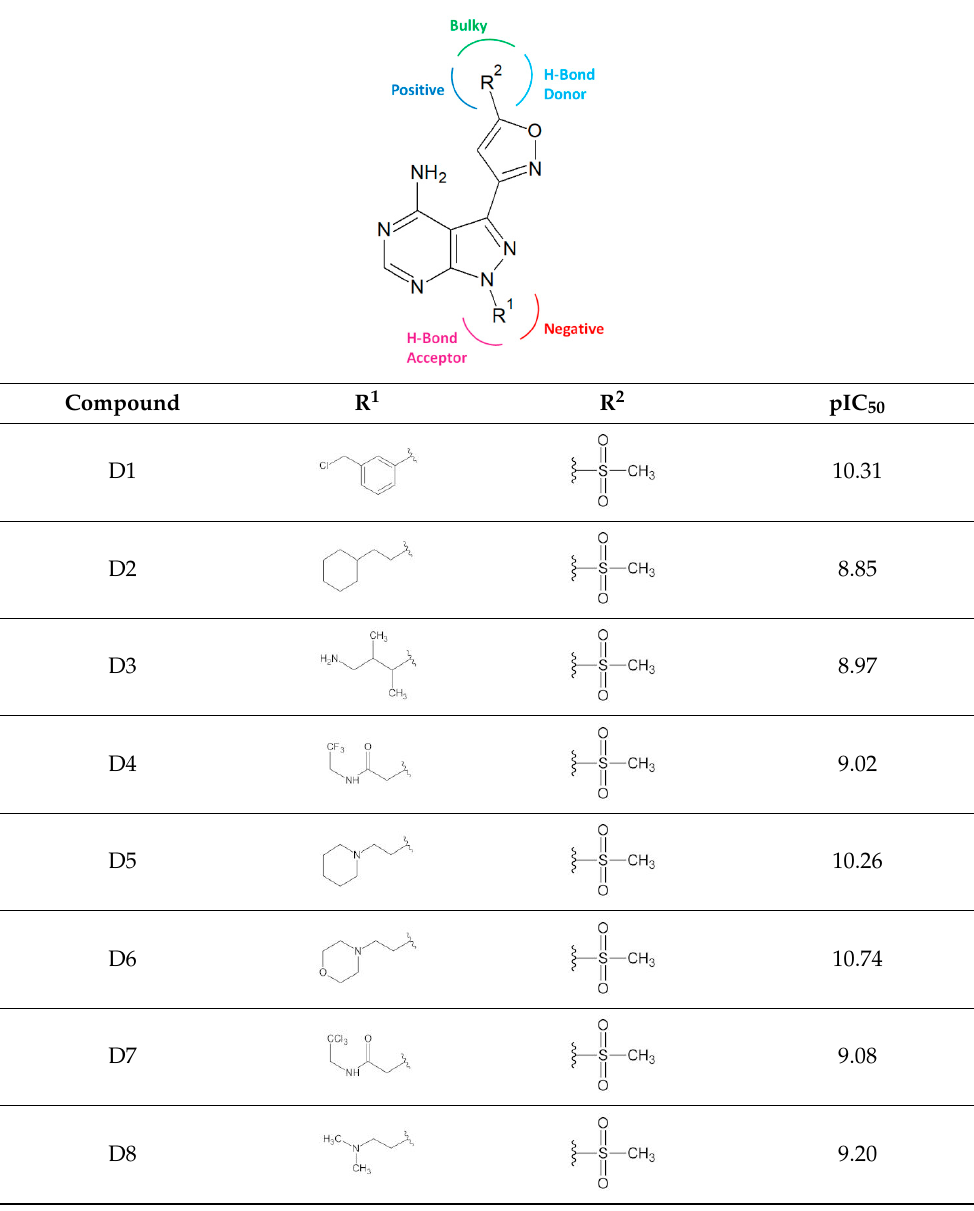
Table 2. The structures and the predicted pIC 50 values of the designed RET kinase